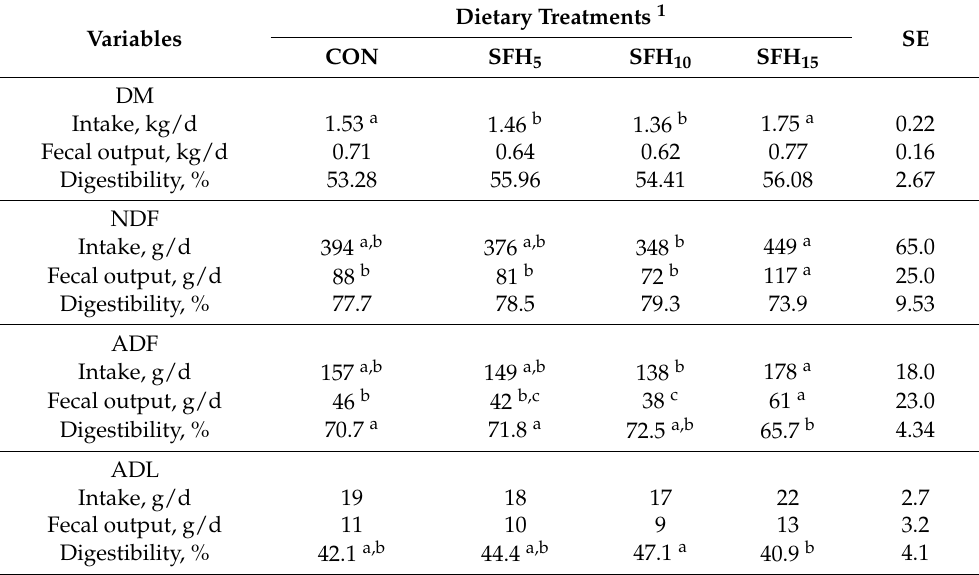
Table 3. Fiber digestibility, excretion, and balance of growing lambs fed the experimental diets containing different levels of sunflower hulls.